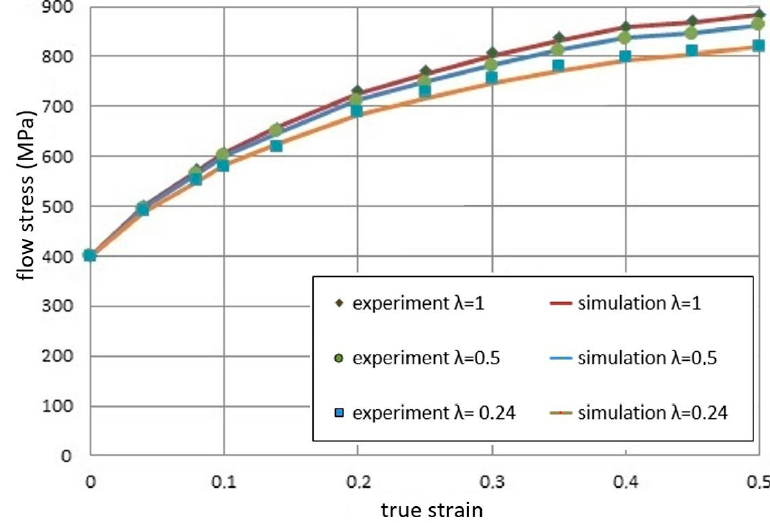
Figure 5. Comparison of the stress–strain curves obtained from the experiment and the simulation.